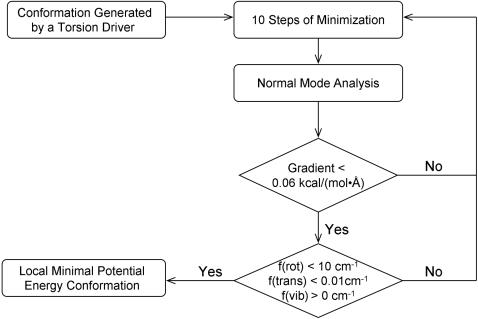
Flowchart of the normal-mode-analysis–monitored energy minimization procedure.mwRMSD stands for mass–weighted root mean square deviation.